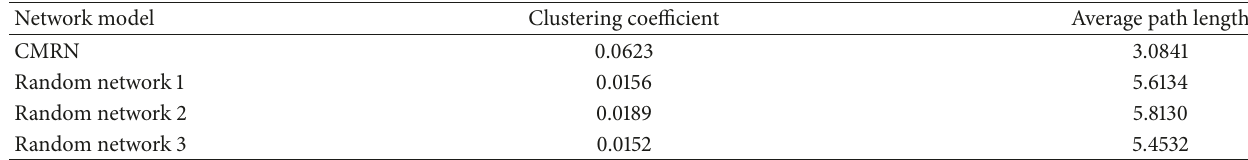
Table 7: The comparison between CMRN and random networks.